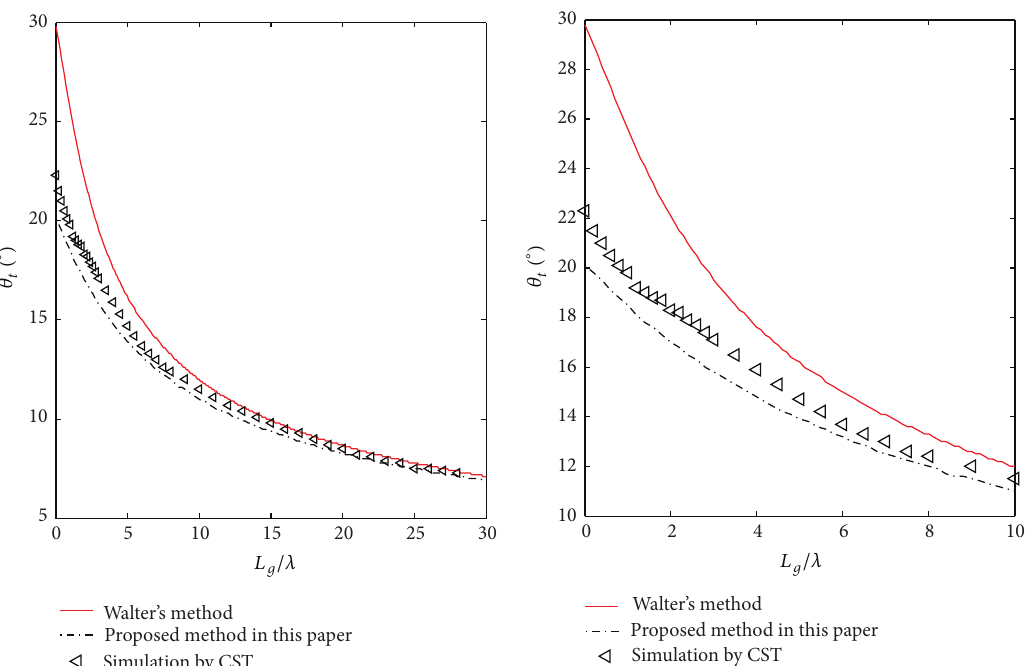
Figure 7: Beam tilt angles of the 10-element antenna when 𝐿 𝑎 = 200 mm, got by the proposed method in this paper, Walter’s method, and CST simulating.